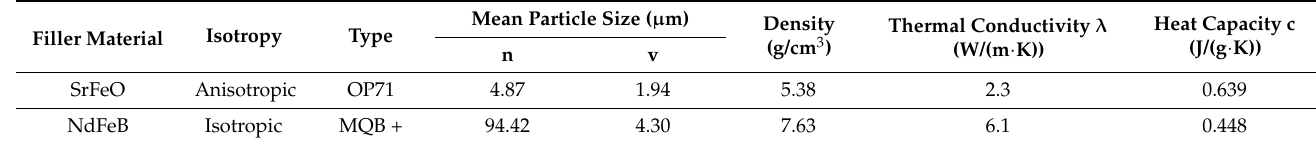
Table 2. Specification of filler material including mean particle size (n: numerical; v: volumetric), density, thermal conductivity λ and heat capacity c (own measurements) (SrFeO: strontium-ferrite- oxide; NdFeB: neodymium-iron-boron).